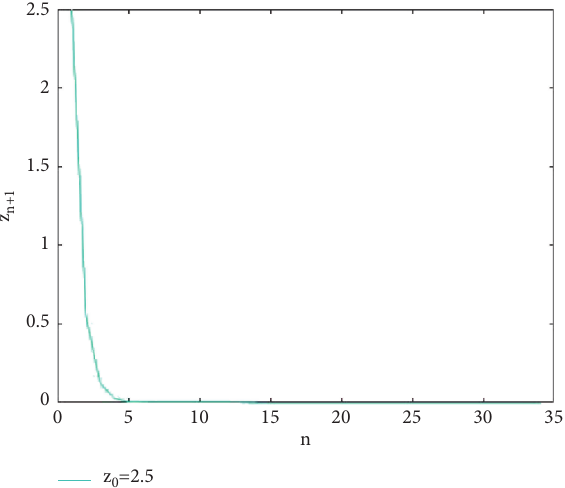
Figure 2: Case II: for the initial value z